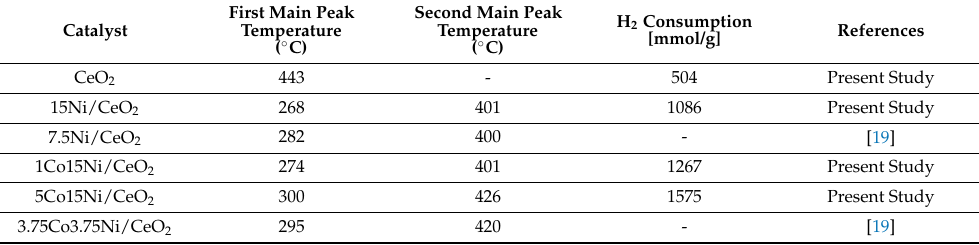
Table 1. Comparison of reduction peaks for similar catalysts with different contents with present